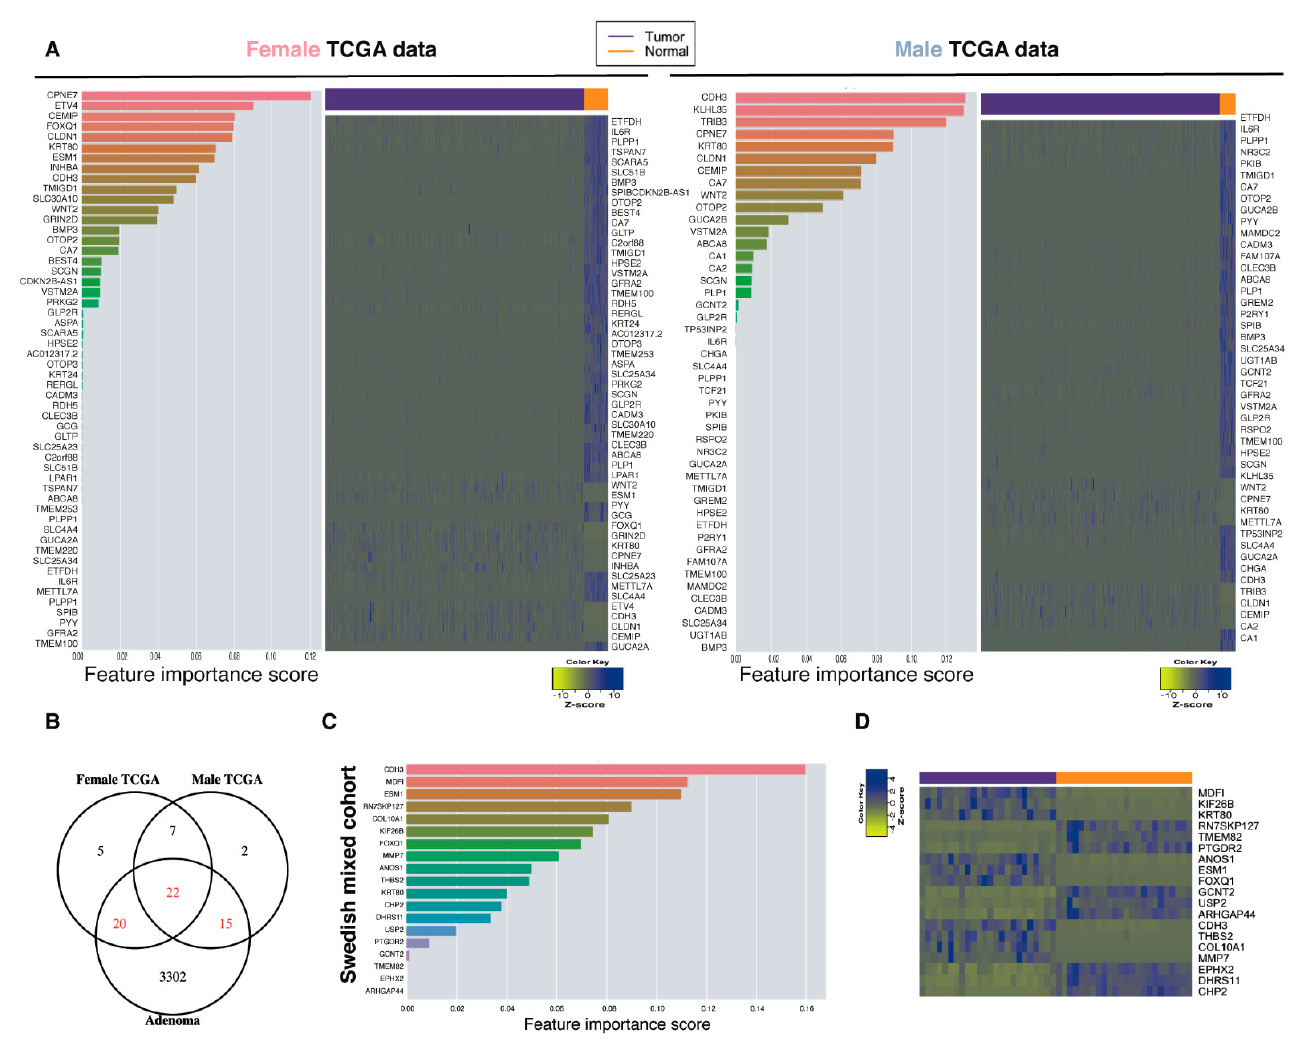
Figure 4. Sex-specific and common top ranked biomarkers with machine learning. ( A ) Top-ranked features with machine learning with RF for the male and female TCGA data, and heatmaps showing the expression (FPKM) of the features in a tumor and normal colon. ( B ) Venn diagram comparing the selected features in the TCGA data with an Italian cohort (GSE8671) containing 32 paired adenomas and colonic mucosa. ( C ) The top-ranked features with machine learning for our mixed cohort, and ( D ) heatmap showing the expression (FPKM) of selected features in a CRC tumor and normal co- lon.